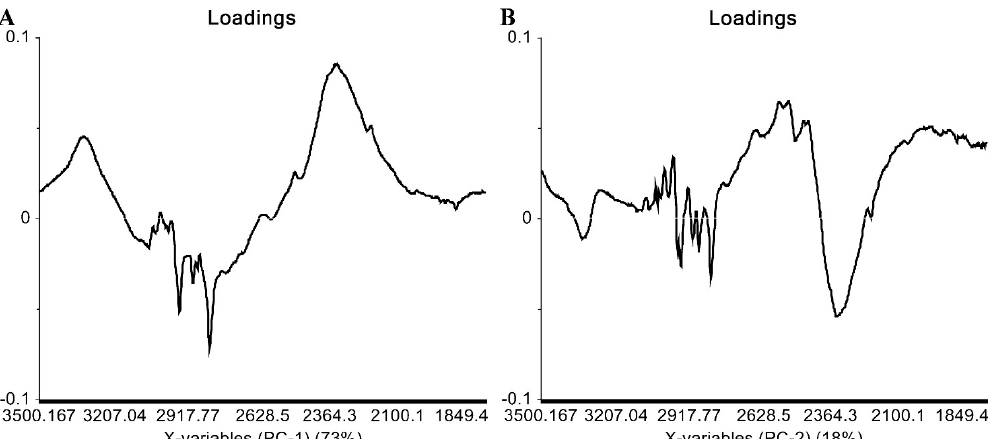
Figure 9. PCA results (loadings graph, PC1) ( A ) and PCA results (loadings graph, PC2) ( B ) of IR spectra (reg. 3500–1750 cm − 1 ).